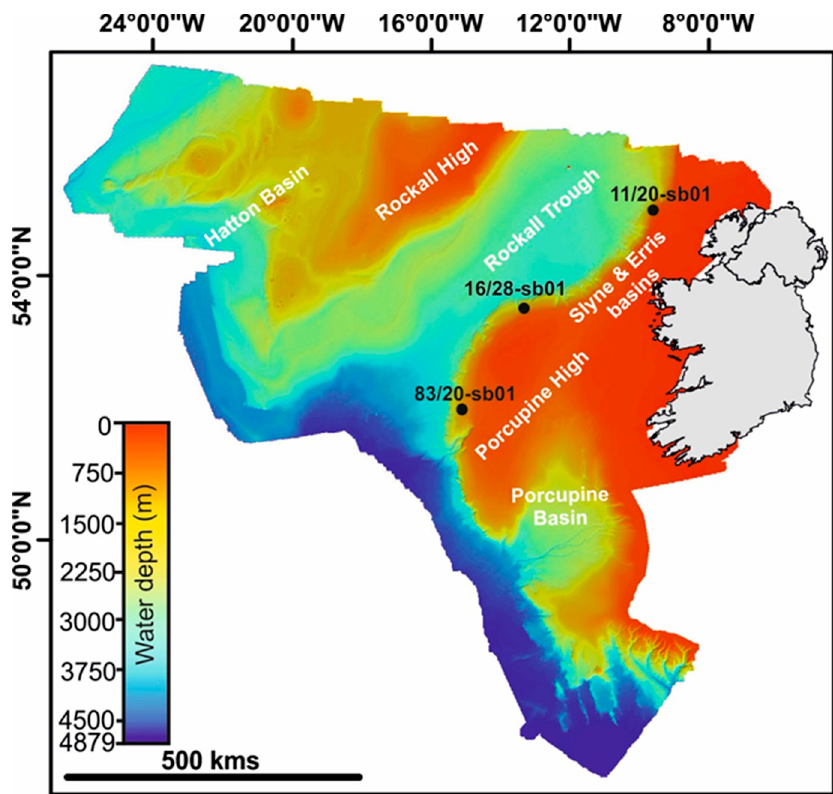
Figure 1. Overview map showing the three boreholes used in this study. Source: INFOMAR, Geological Survey of Ireland.